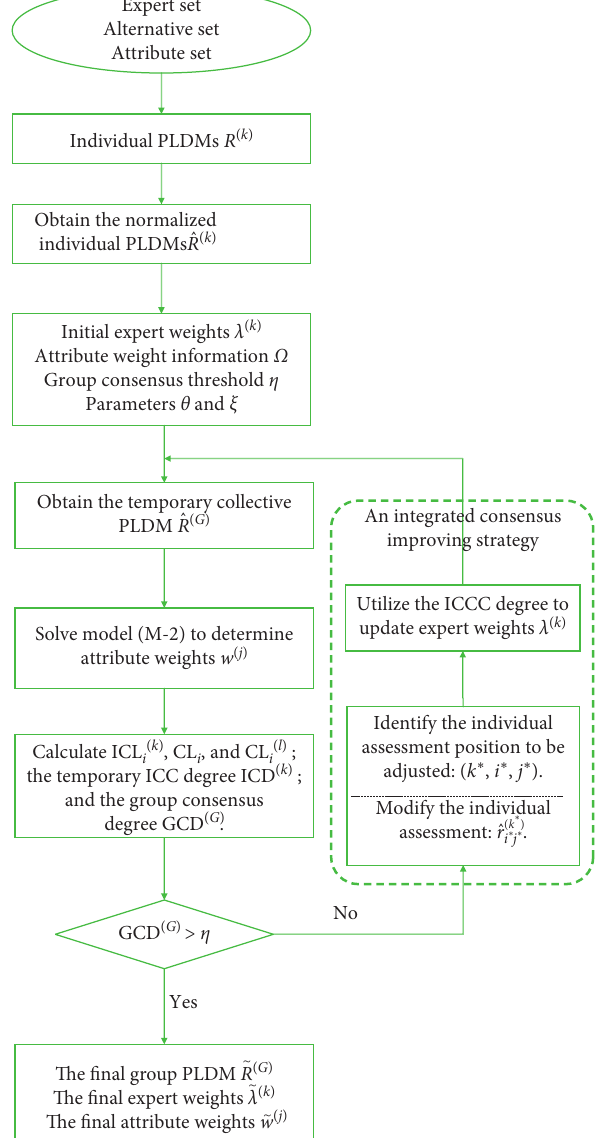
Figure 3: The flowchart of the proposed adaptive